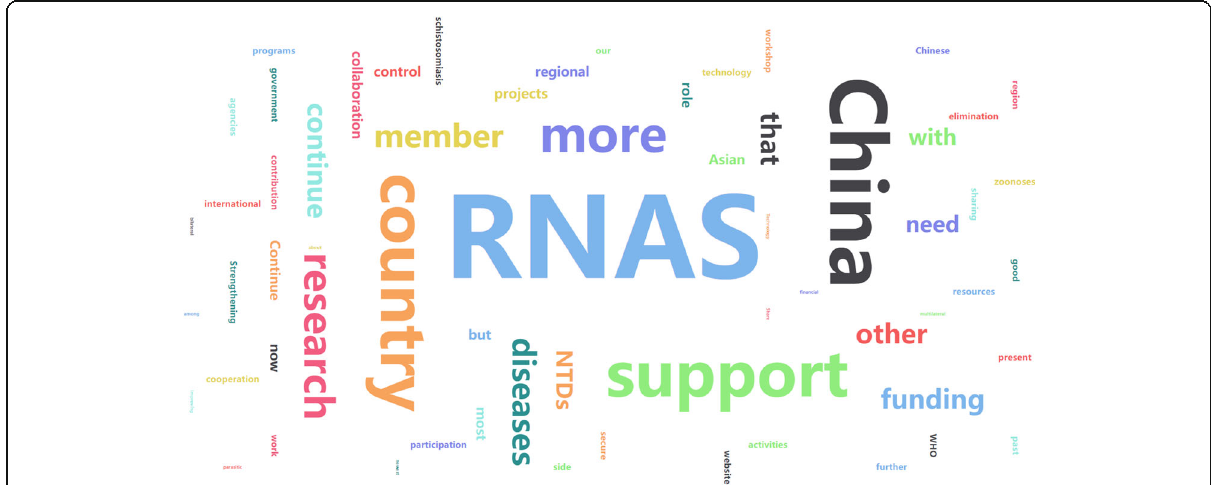
Fig. 4 The highcharts of advice regarding China ’ s future role in RNAS + development according to the survey